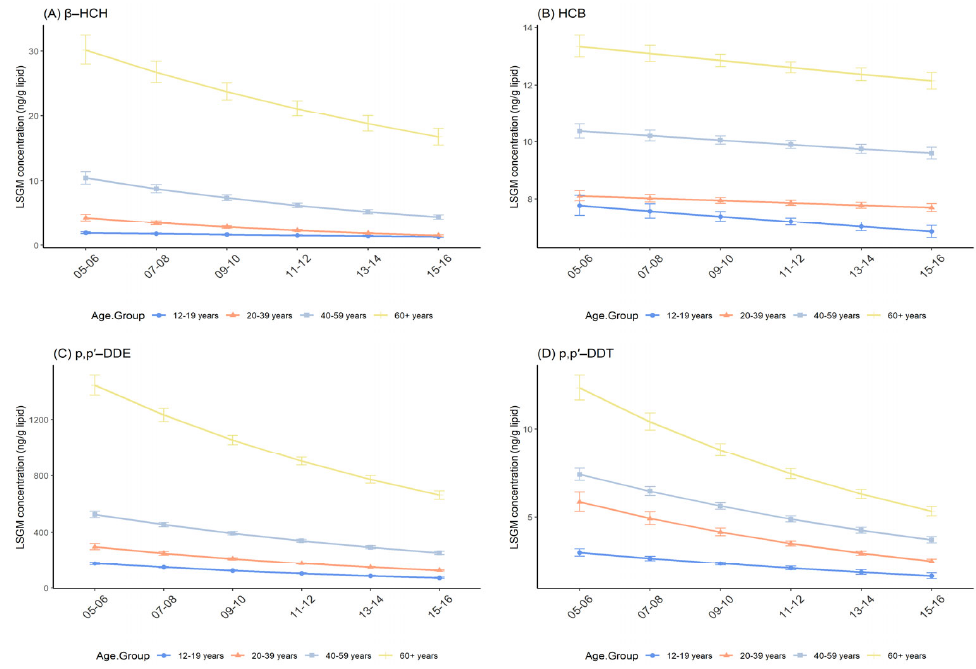
Figure 3. Temporal trends in serum OCP concentrations over survey cycles by age group. Least square geometric mean (LSGM) and 95% confidence interval (95% CI) for each survey cycle estimated from linear regression models adjusted for sex and race/ethnicity; interaction term is survey cycles##age group. Data points represent LSGM, and error bars represent 95% CI. ( A ): β -HCH. ( B ):